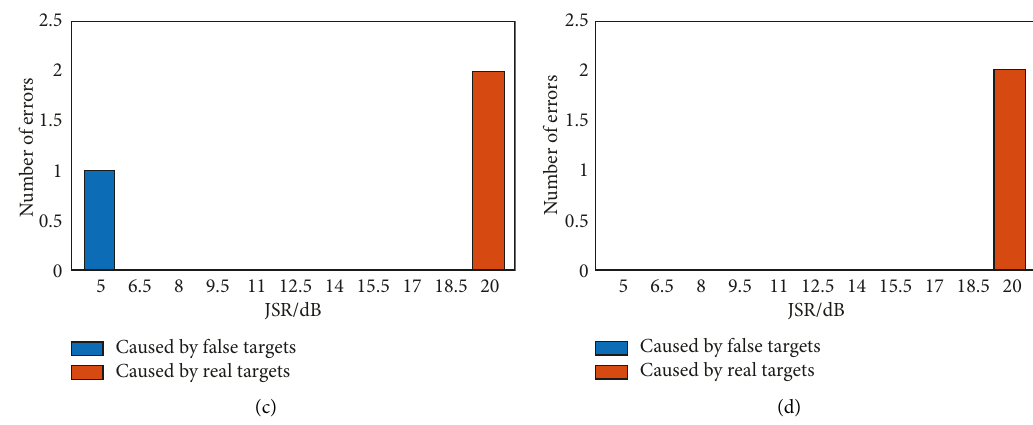
Figure 8: Misidentified target distribution over JSR. (a) Mode 1. (b) Mode 2. (c) Mode 3. (d) Mode 4.